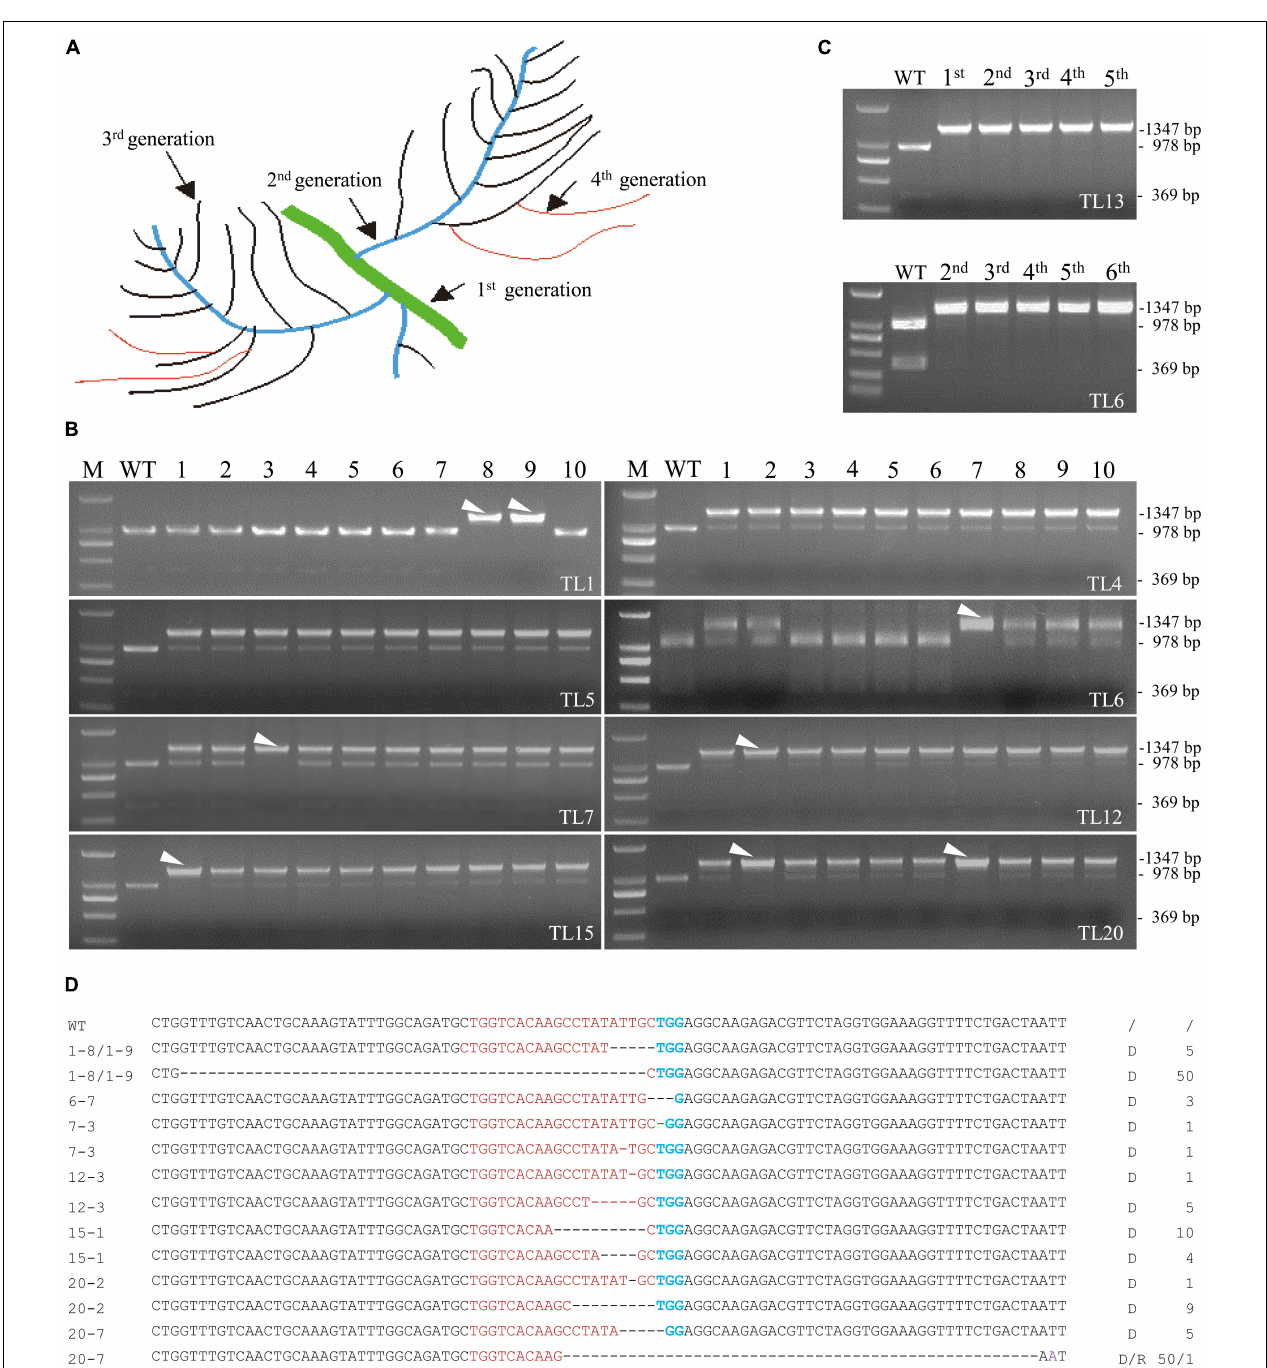
FIGURE 3 | Screening of biallelic or homozygous mutation lines in the 2 nd generation of transgenic hairy root lines. (A) Schematic description of the different generations of hairy roots harvested. (B) Identification of eight biallelic or homozygous hairy root mutation lines in the 2 nd generation of lines 1, 4, 5, 6, 7, 12, 15, and 20. DNA samples from independent lines were analyzed for mutations using the PCR/restriction endonuclease assay. M, 2 kb DNA maker. WT, digested wild-type control; the 1,347 bp band corresponding to MtPDS was cut into two bands, 978 and 360 bp in size, by the Mwo I restriction endonuclease. Lanes 1–10, digested PCR products of independent transgenic hairy roots from the 2 nd generation of TL1, TL4, TL5, TL6, TL7, TL12, TL15, and TL20 with Mwo I. White arrowheads indicate the bands amplified from biallelic or homozygous hairy root mutation lines. (C) PCR/restriction endonuclease assay of five successive generations of line 6 (2 nd to 6th) and line 13 (1 st to 5th). In all lines of each generation, the 1,347 bp band could not be digested. (D) Types of mutations in the biallelic or homozygous hairy root mutation lines screened from the 2 nd generation of hairy roots. Red and green bases indicate the target sequence and PAM region, respectively. Deletions are indicated by dashed lines. d#, number of bases deleted from the target site. r#, number of bases replaced at the target site.